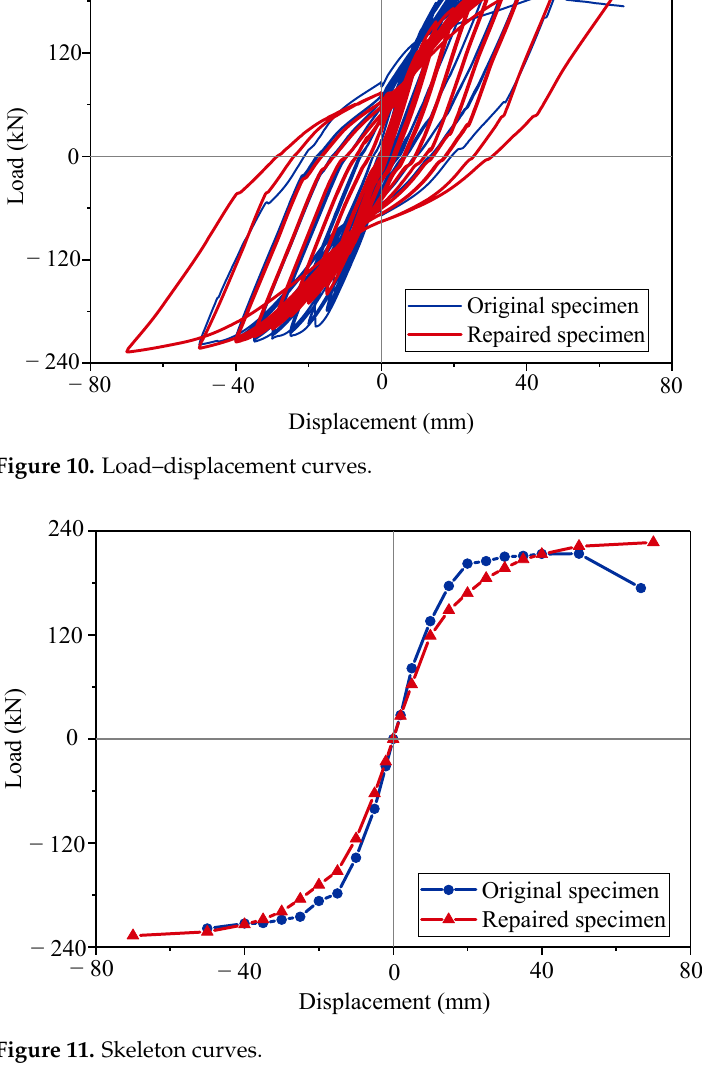
( b ) Repaired specimen Figure 12. The standard deviation for the peak loads at each displacement level: ( a ) standard devi- ation of the original specimen; ( b ) standard deviation of the repaired specimen.